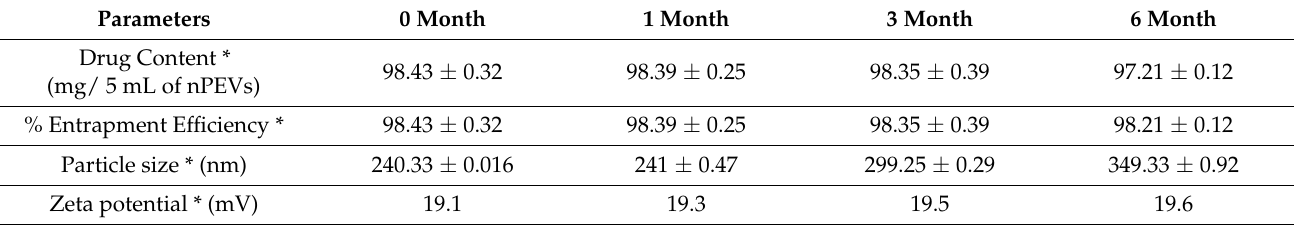
Table 6. Stability study of CMFG-ITZ-nPEVs